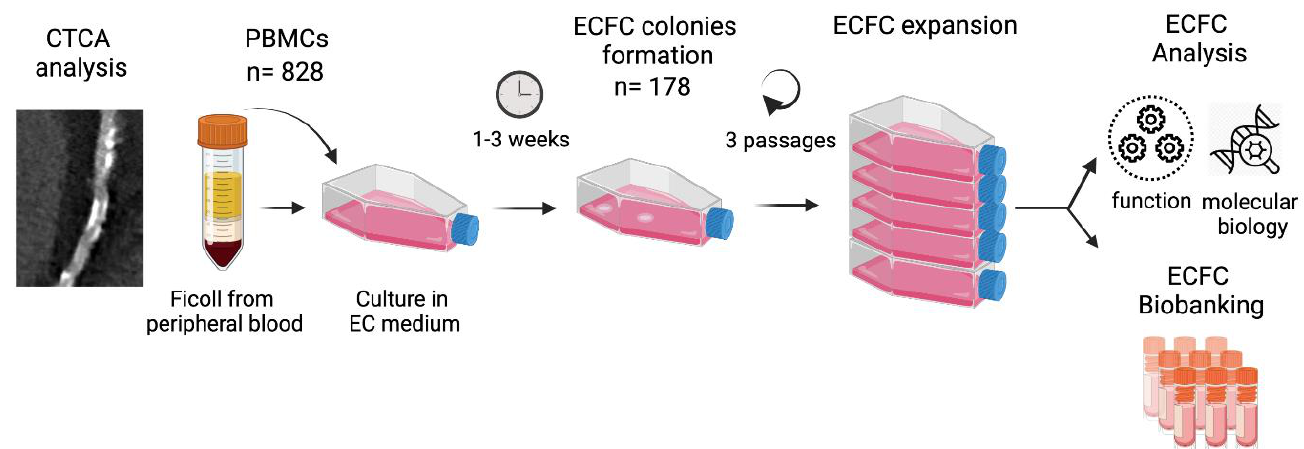
Figure 1. Schematic of the workflow of the study. CTCA: Computed Tomography Coronary Angiography, EC: Endothelial Cells, ECFC: Endothelial Colony Forming Cells, PBMCs: Peripheral Blood Mononuclear Cells. Created with BioRender.com (accessed on 15 September 2021)